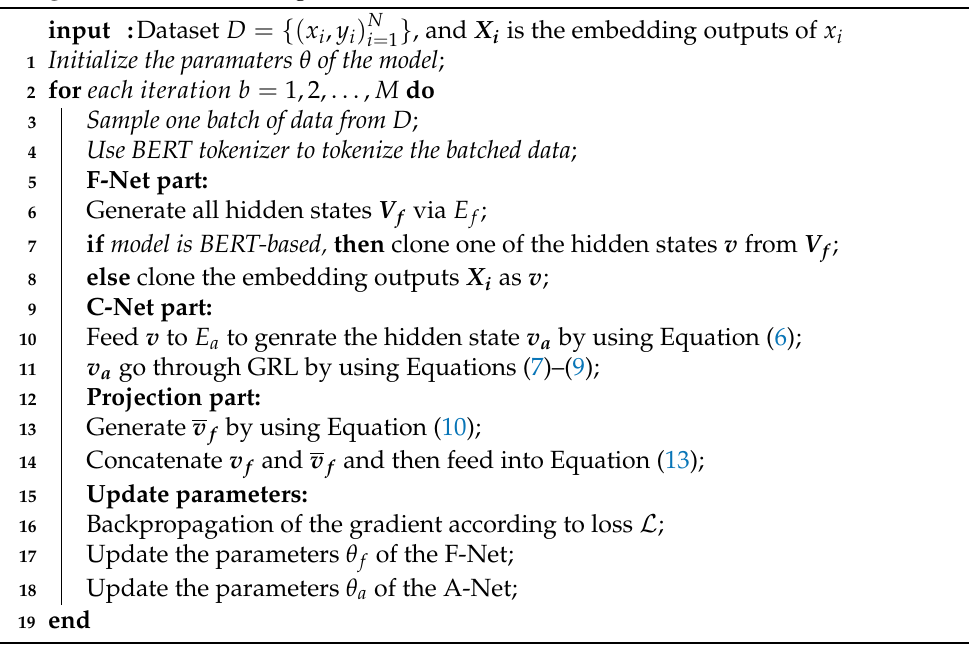
Algorithm 1: Feature Augmentation